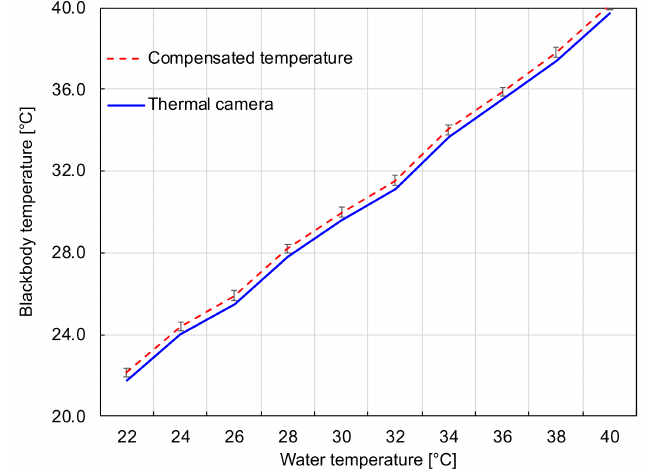
Figure 12. Temperature differences between the measurements of the thermal camera and the standard thermometer. The red dashed line represents the ground truth values and the blue solid curve corresponds to the values measured by the calibrated